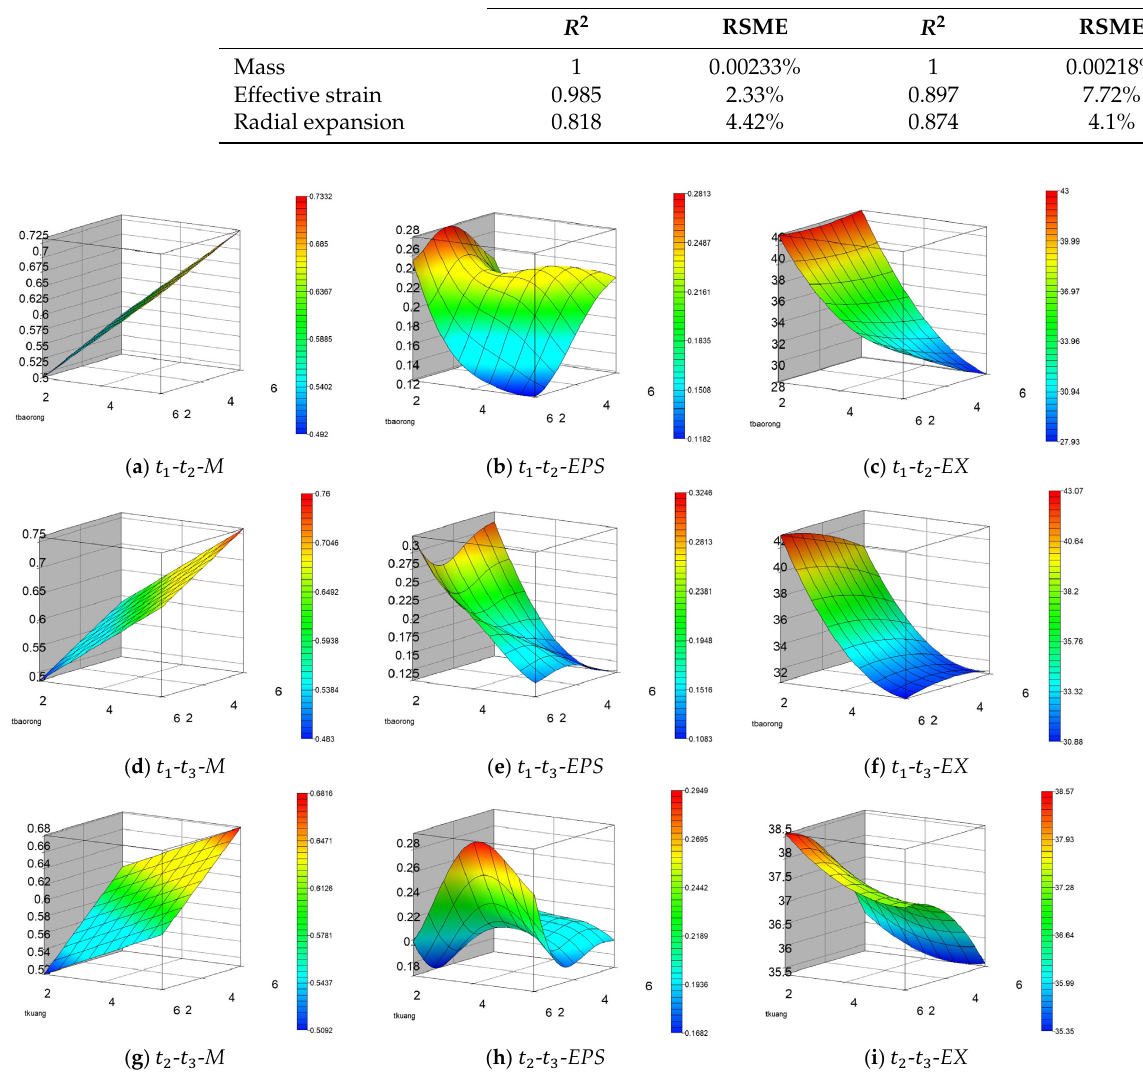
Figure 11. The result of surrogate model.